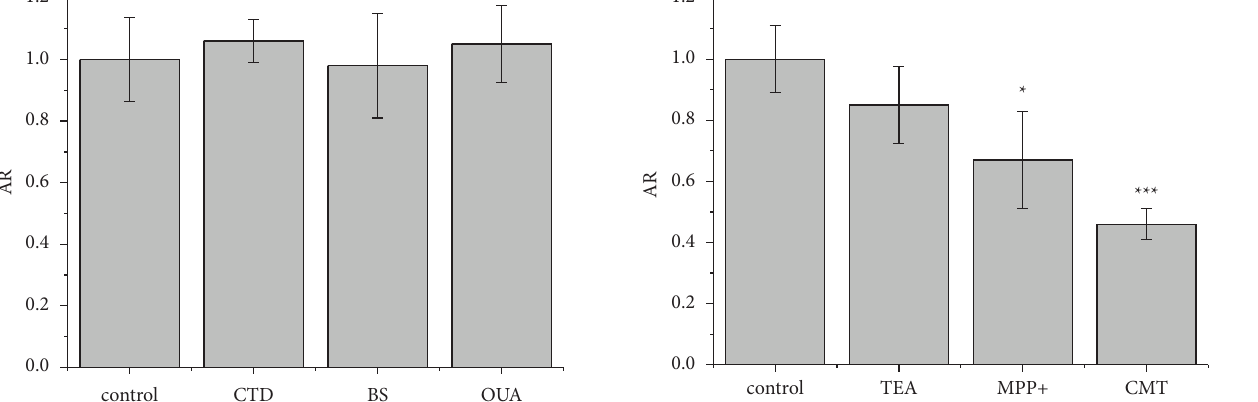
Figure 6: AR in A2780 cells treated for 1h with 2 (10 μ M) in the absence (control) or in the presence of inhibitors cytochalasin D (CTD pretreatment, 10 μ M), O-benzylserine (BS, cotreatment, 1mM), or ouabain (OUA, pretreatment, 1 mM). Data are the mean ± SD of three independent replicates and were compared using one-way analysis of variance (ANOVA) with the Tukey post- hoc test. Statistical analysis (inhibitors vs. controls): no indica- tion � not signifcant.